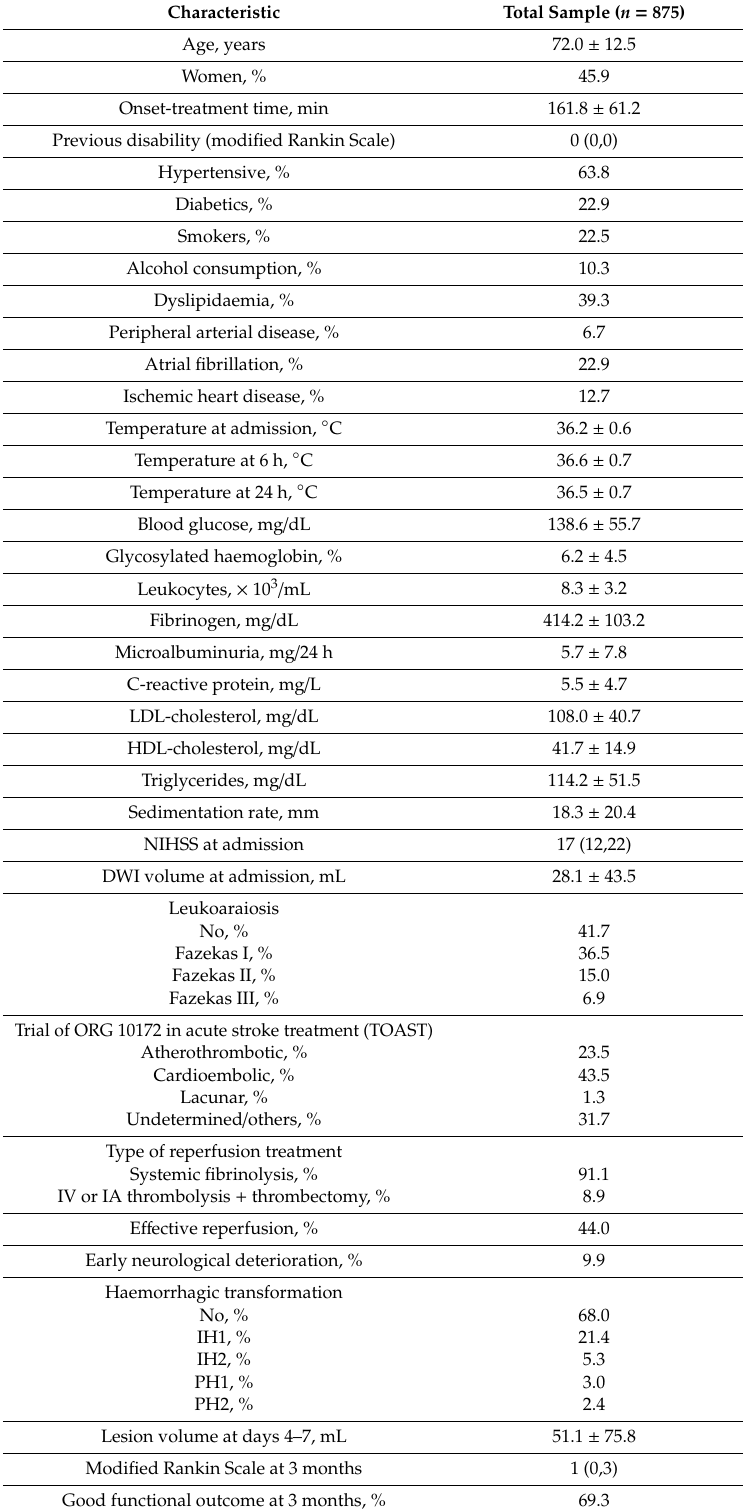
Table 1. Description of the 875 patients included in the